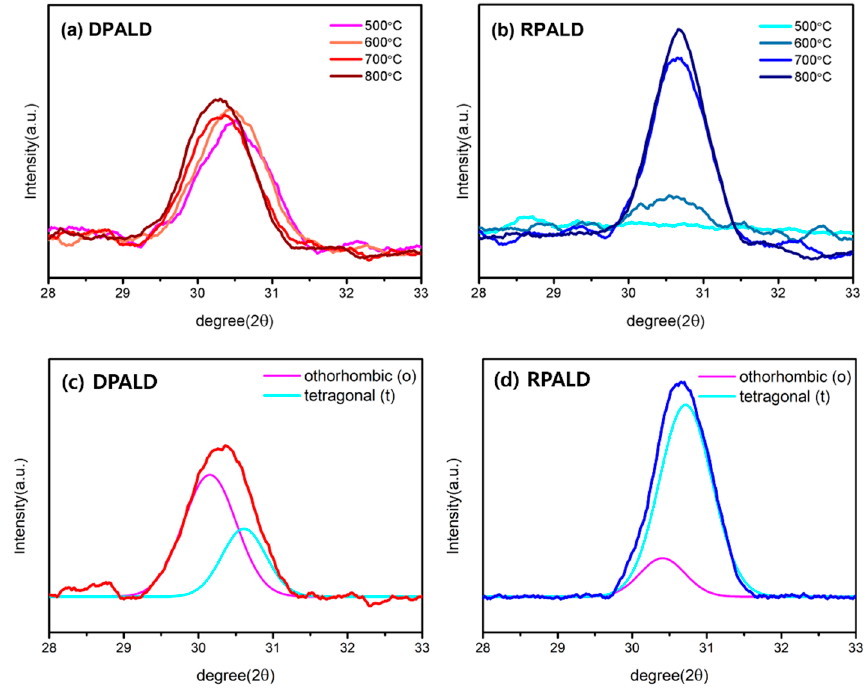
Figure 4. HZO thin films deposited by two PEALD methods: ( a , b ) XRD patterns, according to the RTA temperature, and ( c , d ) peak separation of the XRD pattern for heat treatment at the RTA temperature of 700 °C.